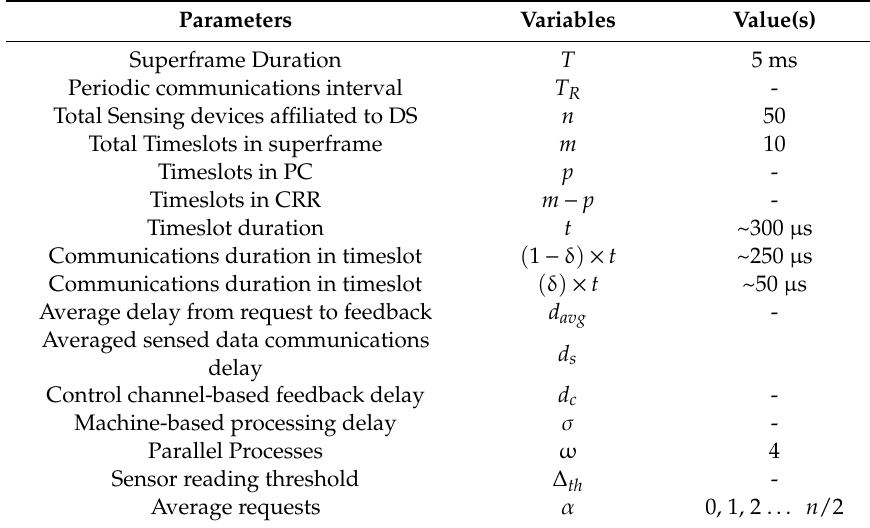
Table 1. System Parameters, symbols and values.